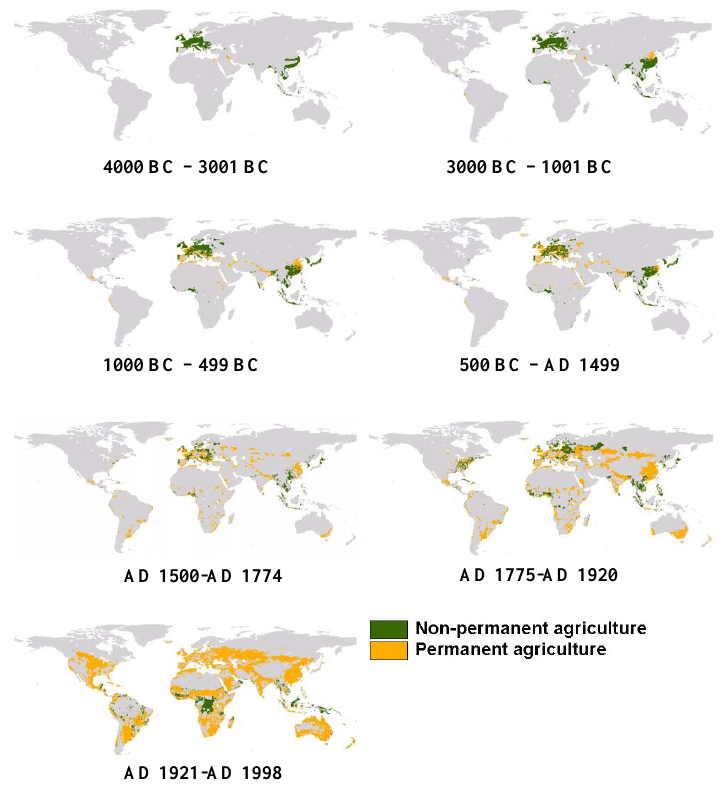
Fig. 2. Reconstructions of the spatial extent of permanent and non-permanent agriculture for seven time slices of the Holocene (modified Gaillard et al. Figure 2 from Olofsson and Hickler, 2008). The reconstructions are based on archaeological maps of the spread of different societal forms, HYDE suitability (see text for